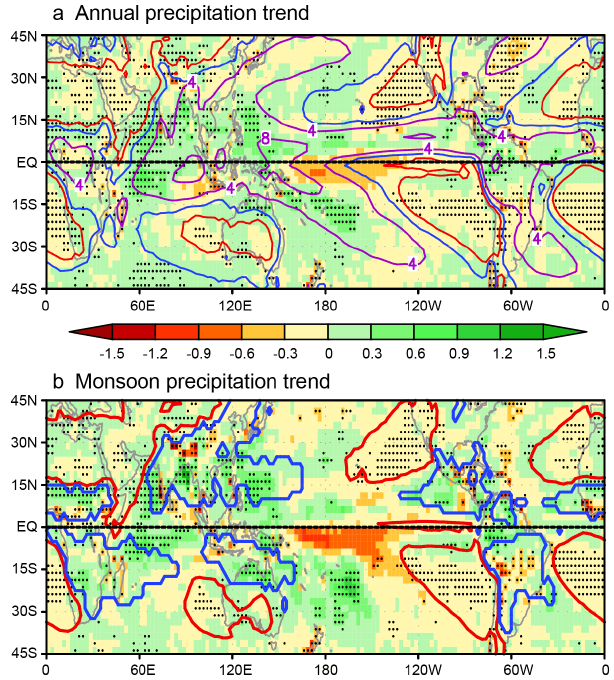
Figure 23. Recent trends (1979–2008) in (a) global annual precipi- tation and (b) precipitation in the summer monsoon season (i.e., MJ- JAS for NH and NDJFM for SH) in units of mmday − 1 decade − 1 . The significance of the linear trends was tested using the trend-to- noise ratio. Areas passing 90% confidence level were stippled. The GPCP data were used. In (a) , the climotological annual mean pre- cipitation rate was shown by contours (1 (red), 2 (blue), 4, and 8 (purple) mmday − 1 ). In (b) , the monsoon and desert regions as de- fined in Fig. 2 were delineated by blue and red,